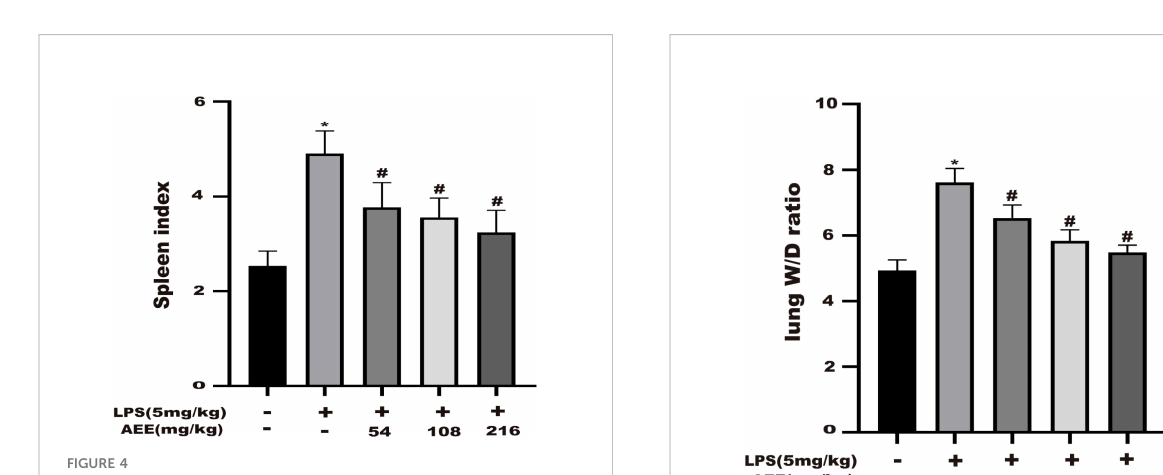
FIGURE 4 Effect of AEE on splenic index in LPS-induced ALI rats. Values are presented as the means ± SD where applicable ( n = 8). * P < 0.05 compared to control group, # P < 0.05 compared to LPS group.